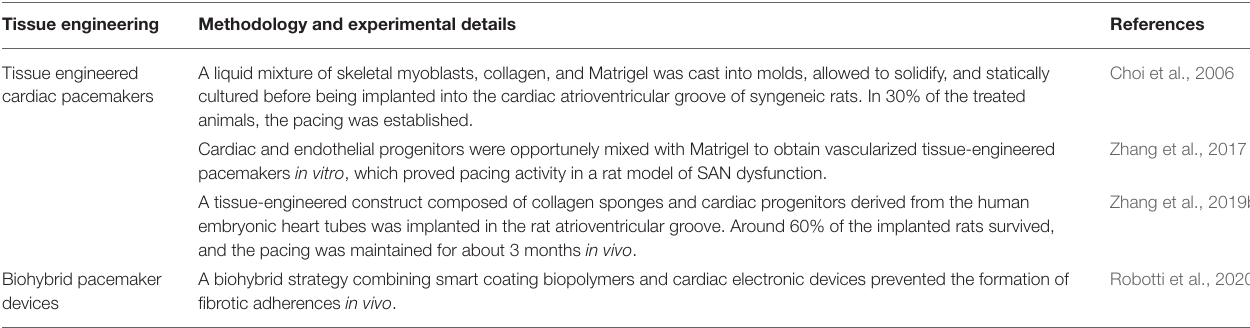
TABLE 6 | Tissue engineering and hybrid biopacemaking